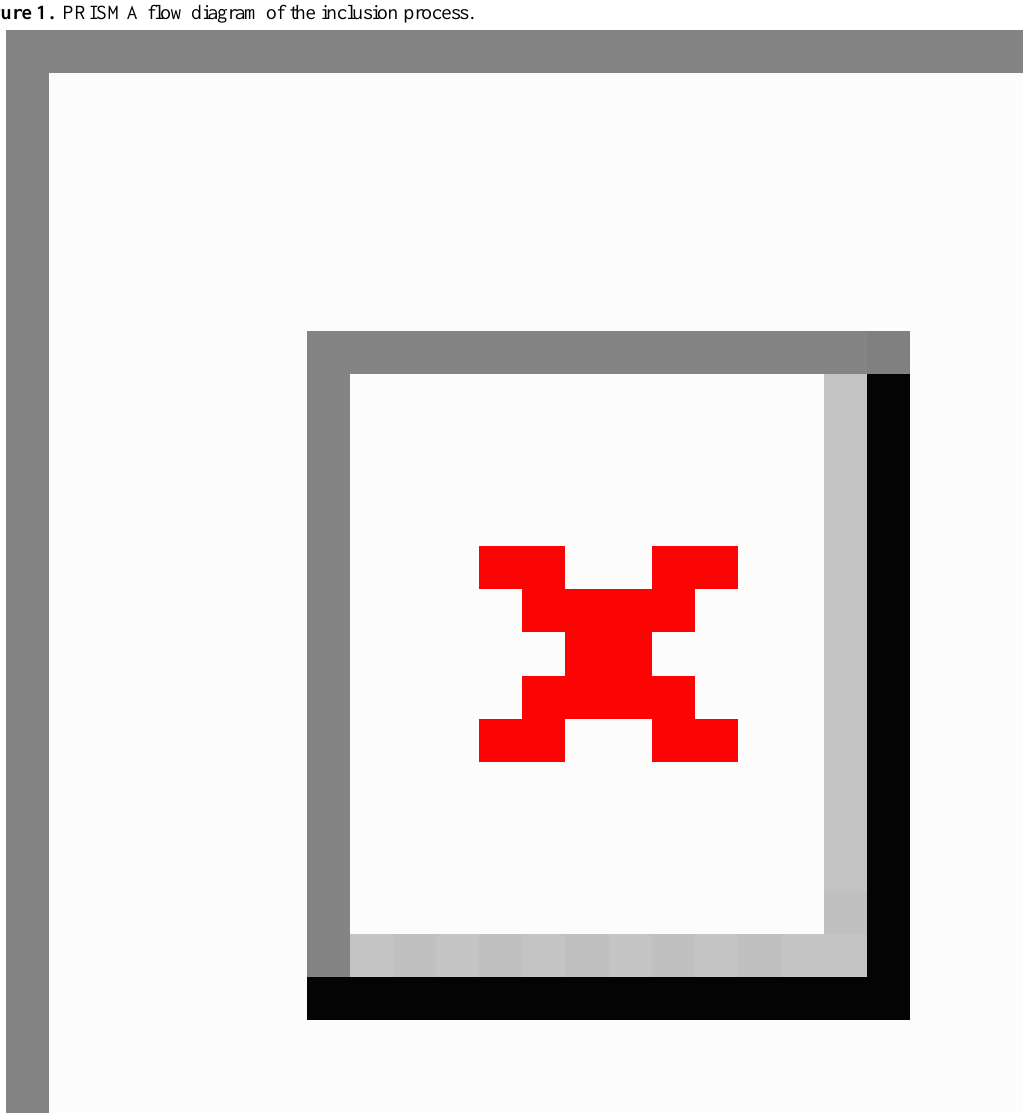
Figure 1. PRISMA flow diagram of the inclusion